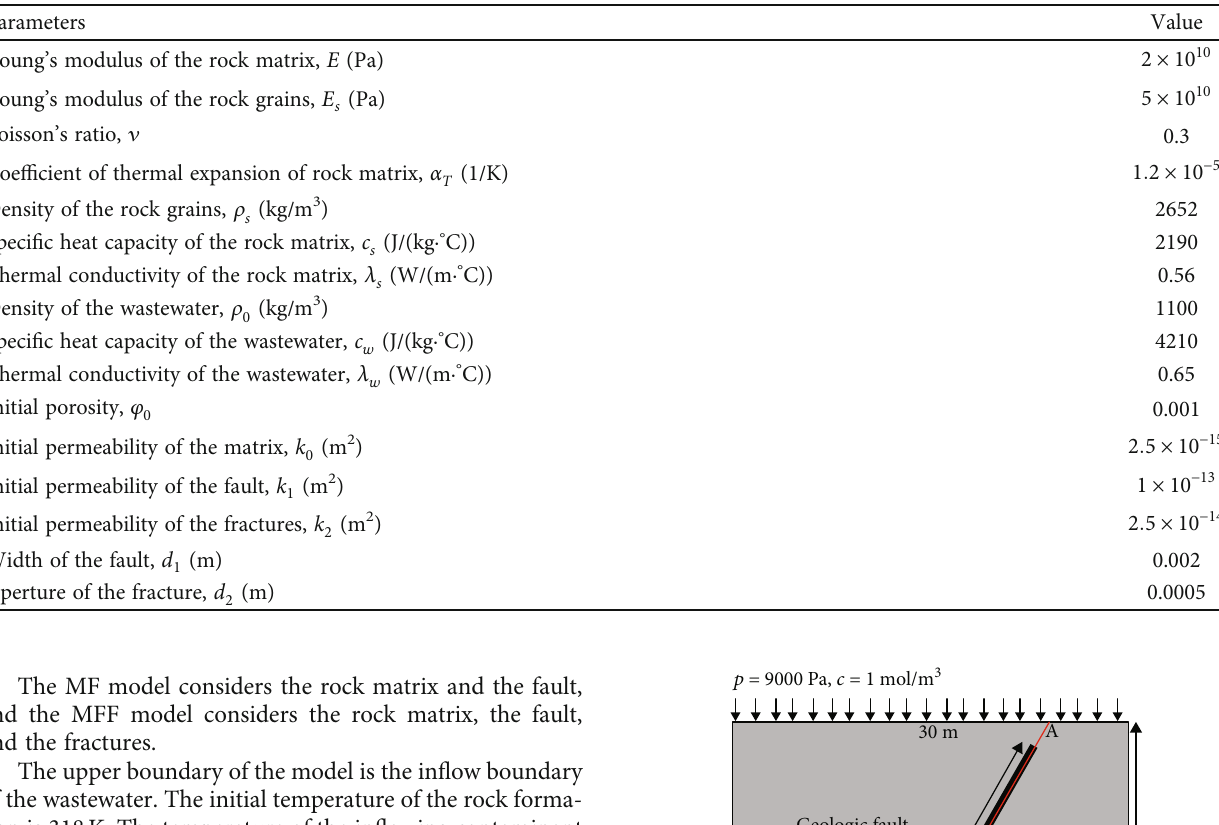
Table 1: The parameters and values.